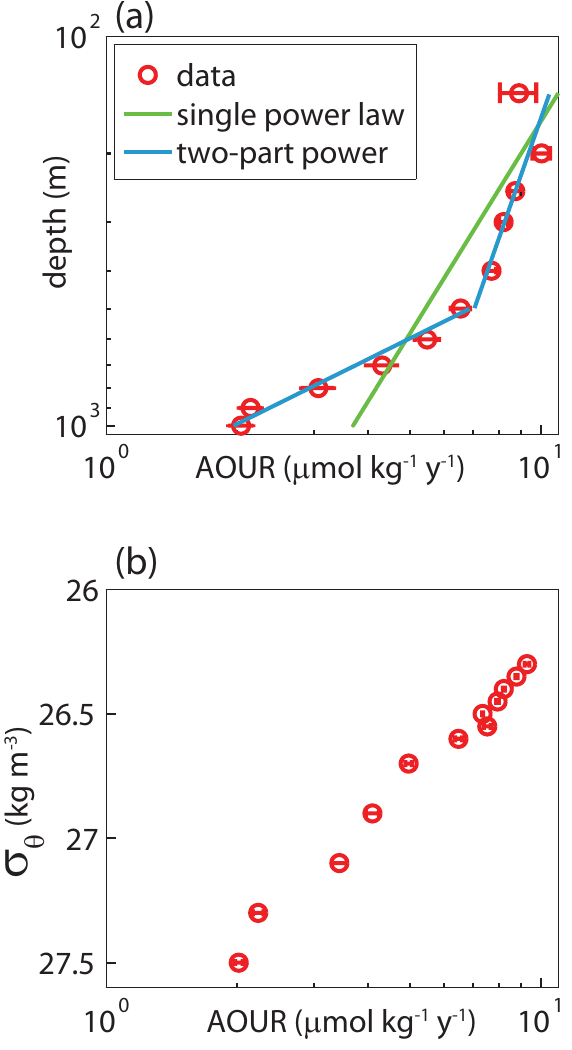
Fig. 5. (a) AOUR averaged on depth surfaces (red circles) plotted vs. depth on a log-log plot. A single power law (green) was not a good fit for all the data so instead a piecewise, two-part power law function with a break at 500m was fit to the data (cyan). The equation for the piece-wise fit it is AOUR = 9.67(depth/100) − 0 . 12 for the upper part of the fit and AOUR = 210.58(depth/100) − 2 . 03 for the lower part of the fit. (b) AOUR averaged on density surfaces (red circles) plotted vs. density on a semi-log plot. Note the error bars (1 σ standard error of mean) are smaller when AOUR is averaged over density